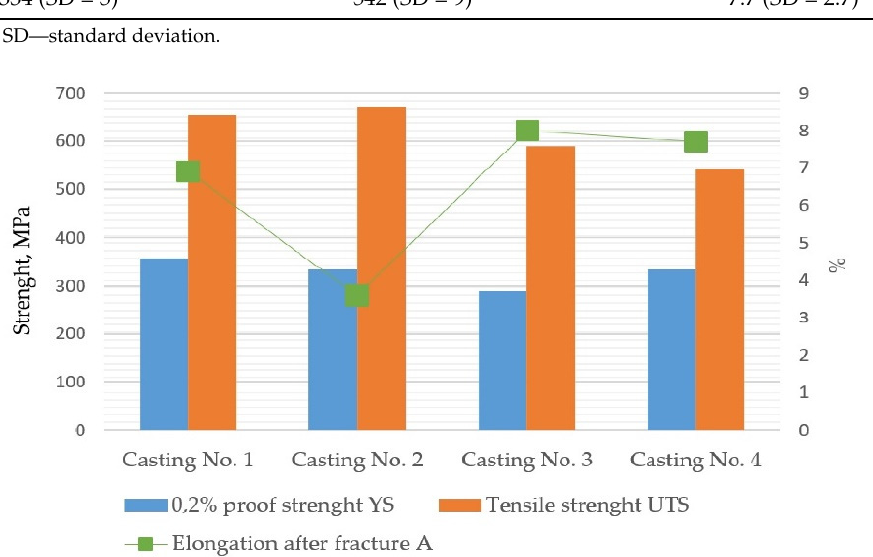
Figure 10. The mechanical properties of the tested samples obtained in the tensile